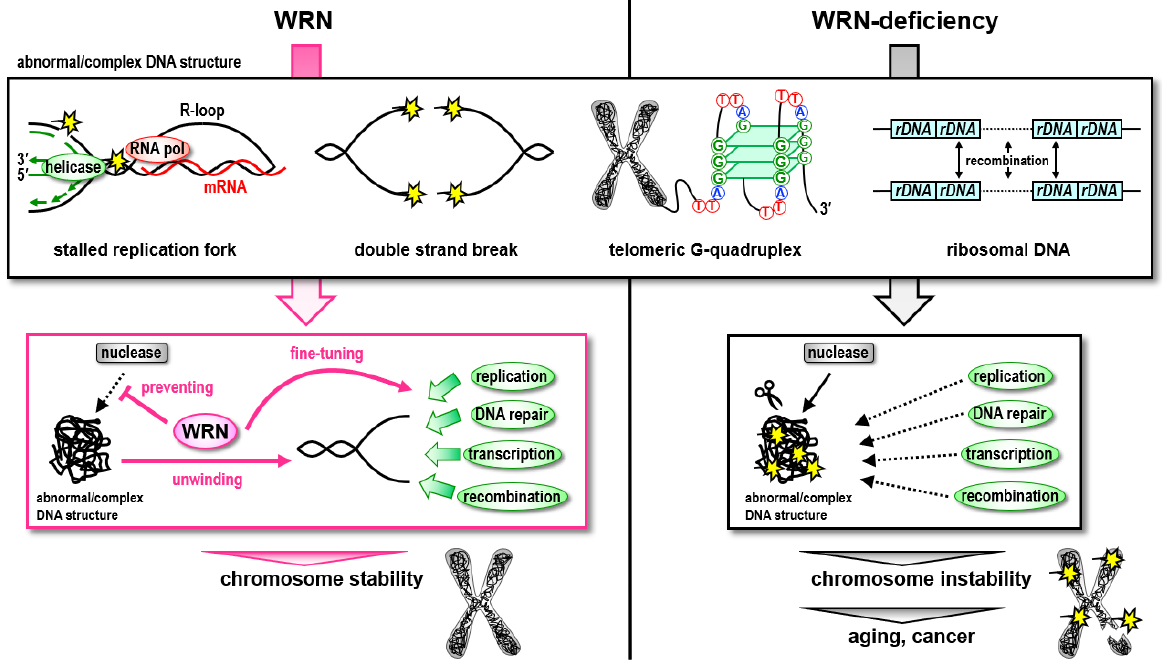
Figure 3. Summary of roles of WRN helicase in DNA repair. WRN helicase may regulate DNA repair pathway choice. The compensatory mechanisms fill the gap to repair DNA lesions in the cells deficient in WRN helicase.